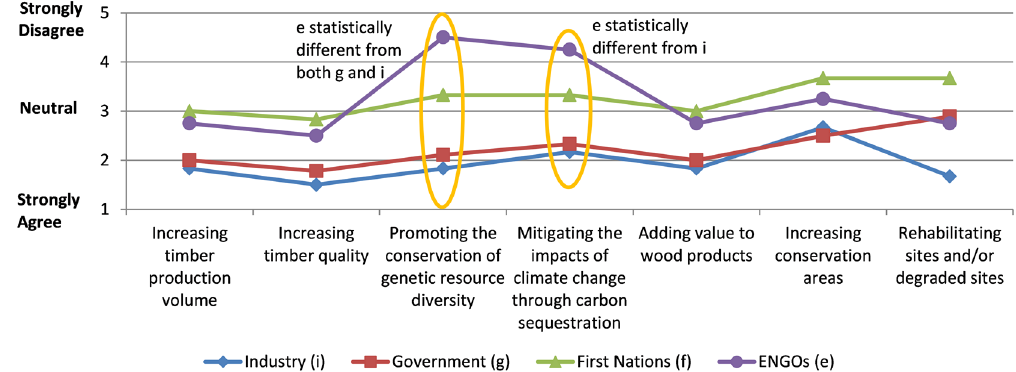
Figure 5. Mean response by group for usefulness of MAS as a tool if used in a forest management framework in BC. Circles denote significant differences revealed through ANOVA and Scheffé’s Tests ( α = 0.05). Notes indicated where the statistically significant differences exist with i, g, f, and e denoting mean scores for Industry, Government, First Nations, and ENGOs, respectively.